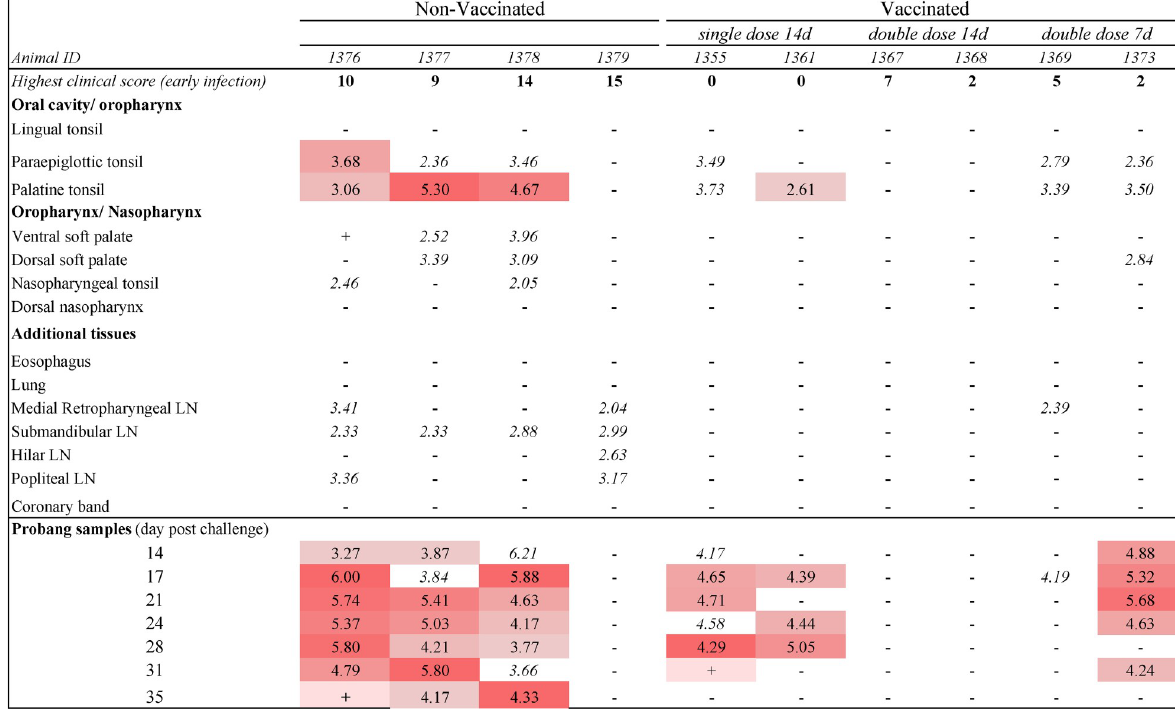
Fig 4. FMDV detection in ovine tissues and oropharyngeal fluid samples during persistent infection. FMDV detection in tissue samples obtained at 35 days post challenge. The vaccinated cohort included 2 animals from each of 3 study groups subjected to different vaccination regiments; single dose vaccine at 14 days prior to virus challenge, double dose vaccine at 14 days prior to challenge, and double dose vaccine at 7 days before challenge. Highest clinical score represents the maximum cumulative lesion score observed from 0–10 days post virus challenge. Numbers in the table represent log 10 genome copy numbers (GCN)/mg of FMDV RNA in tissue or OPF samples. Color gradient indicates increasing FMDV RNA quantities in samples that were positive by both RT-qPCR and virus isolation. Numbers in uncolored cells indicate quantities of FMDV RNA that were detected in samples that were negative by virus isolation, (+) indicates that virus isolation was positive but FMDV RNA content was below the limit of detection ( < 2.0 log 10 GCN/mg), (-) indicates double-negative